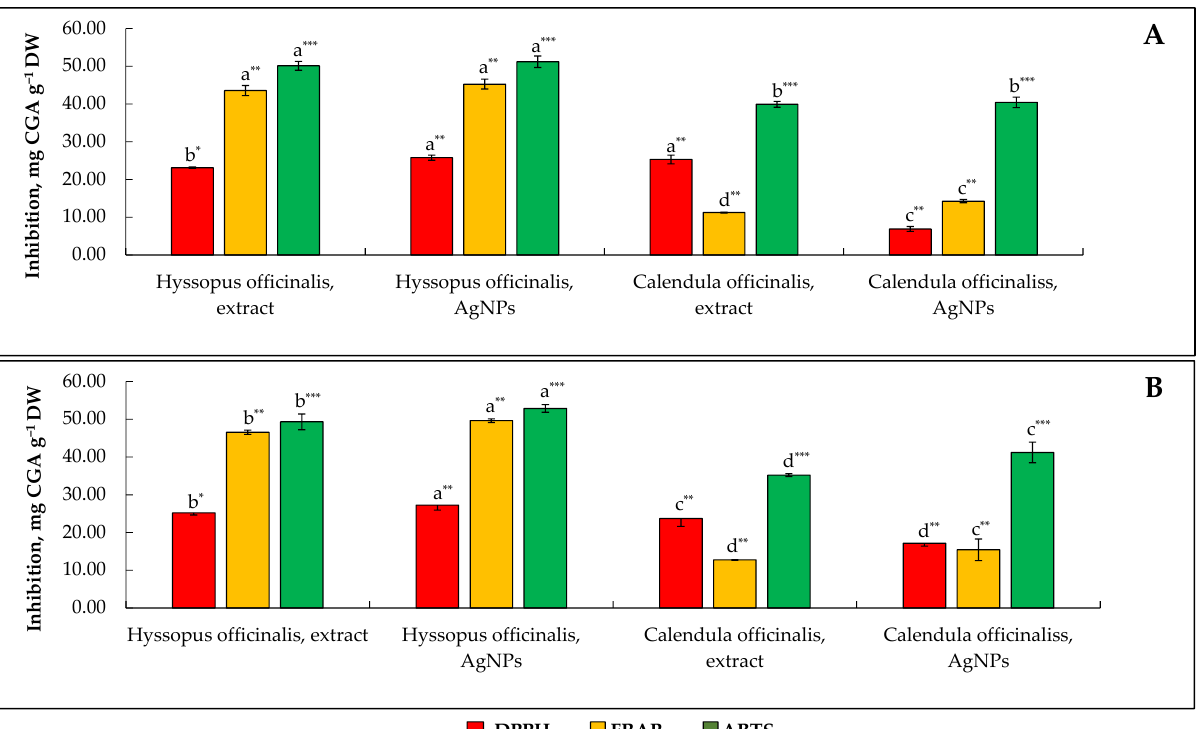
Figure 3. Antioxidant activity of Hyssopus and Calendula water extracts and their mediated silver nanoparticles according to the determination method, i.e., DPPH*, FRAP**, and ABTS***. Note: Values are means ± SD of triplicates (n = 3). Means within the same antioxidant activity assay method with different superscript letters ( a,b,c,d ) are significantly different (one-way ANOVA and Tukey’s test, p ≤ 0.05). SD—standard deviation; DW—on a dry weight basis. ( A ) Extracts and silver nanoparticles diluted in water prior to assay, ( B ) extracts and silver nanoparticles diluted in acidified 80% methanol prior to